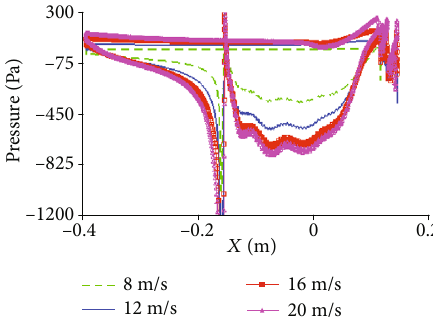
Figure 14: Static pressure distribution curve on the surface of the Fan-wing with a double leading edge winglet ( installationangle = 60 ° , α = 0 °